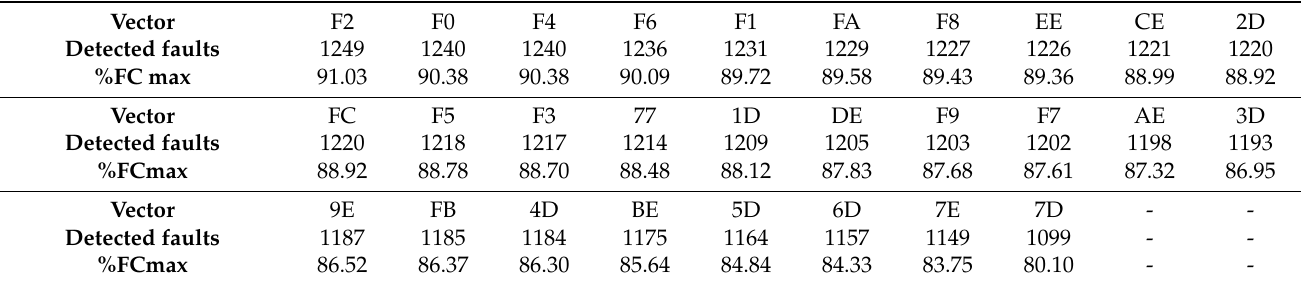
Table 4. First-order vectors and their FC.